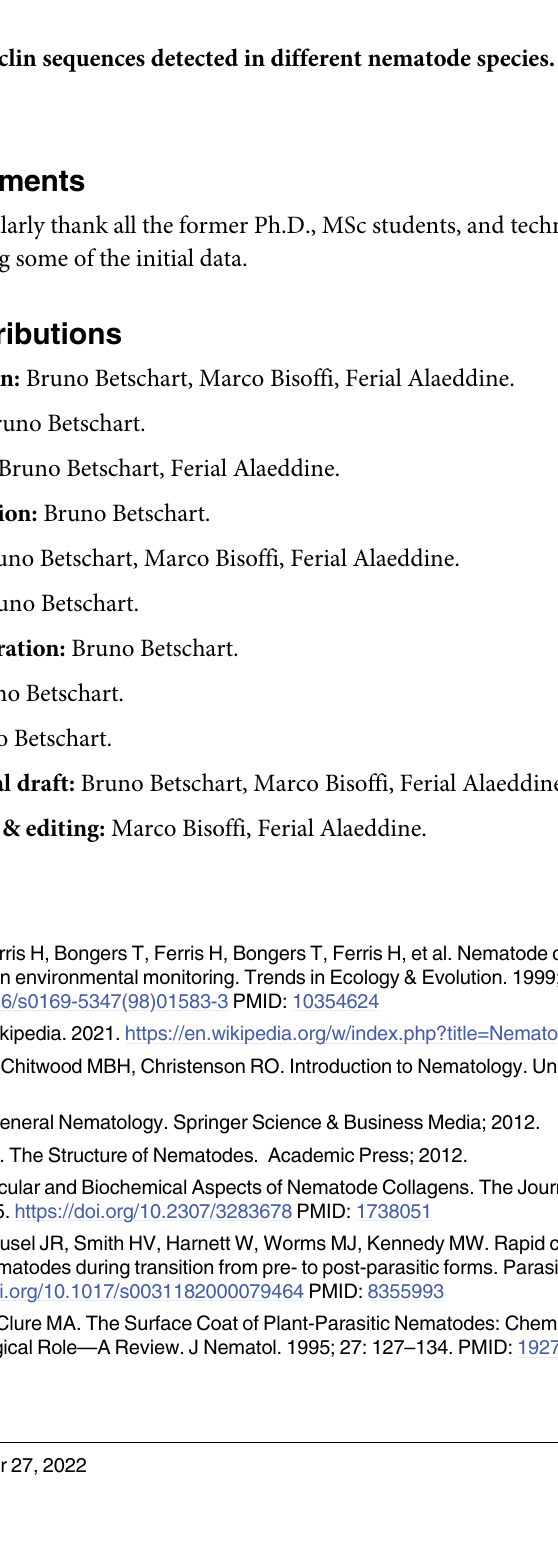
S2 Fig. Scheme of the identification of the complete Asu-epic-1 gene of A . suum . (DOCX) S3 Fig. Comparative alignment of the amino acid sequence of Asu-EPIC-1 with sequences encoded by four cDNA and one TSA clone.